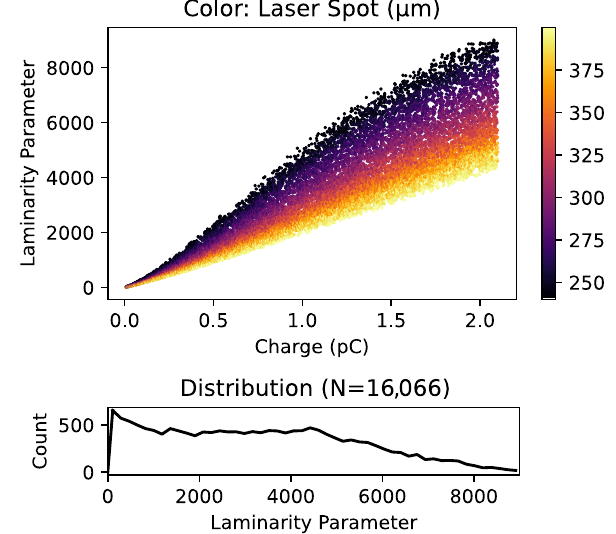
FIG. 4. Top: scatter plot of the laminarity parameter ρ at the solenoid according to Eq. (2) vs the bunch charge for all training datasets. γ ¼ 6 . 8 for this population. The color indicates the laser spot size on the cathode for each dataset. Bottom: distribution of the laminarity parameter.